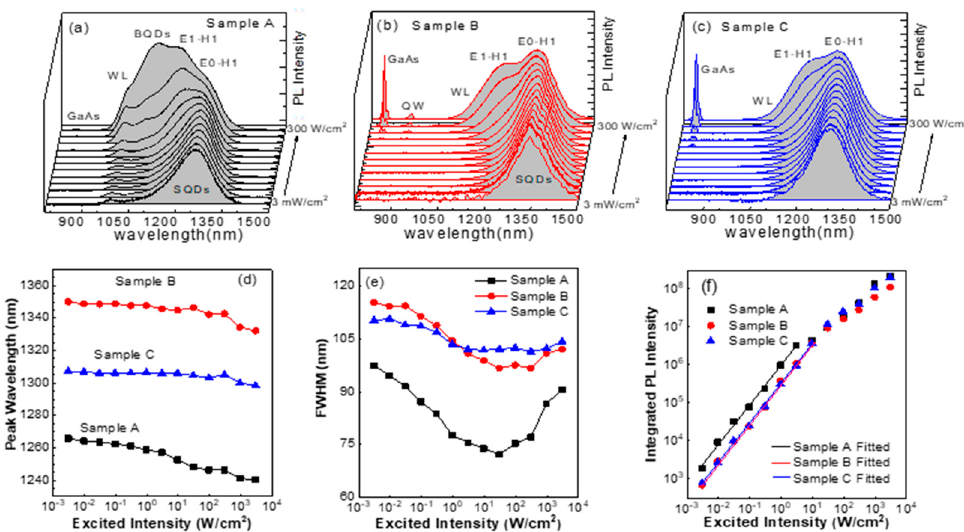
Figure 3. PL spectra measured at 10 K with varied excitation intensity from 3 mW/cm 2 to 3000 W/cm 2 for ( a ) sample A, ( b ) sample B, ( c ) sample C; ( d ) the peak wavelength, ( e ) the FWHM, and ( f ) the integrated intensity for the E0-H1 PL peak of SQDs are plotted against excitation intensity, as extracted from ( a – c ).